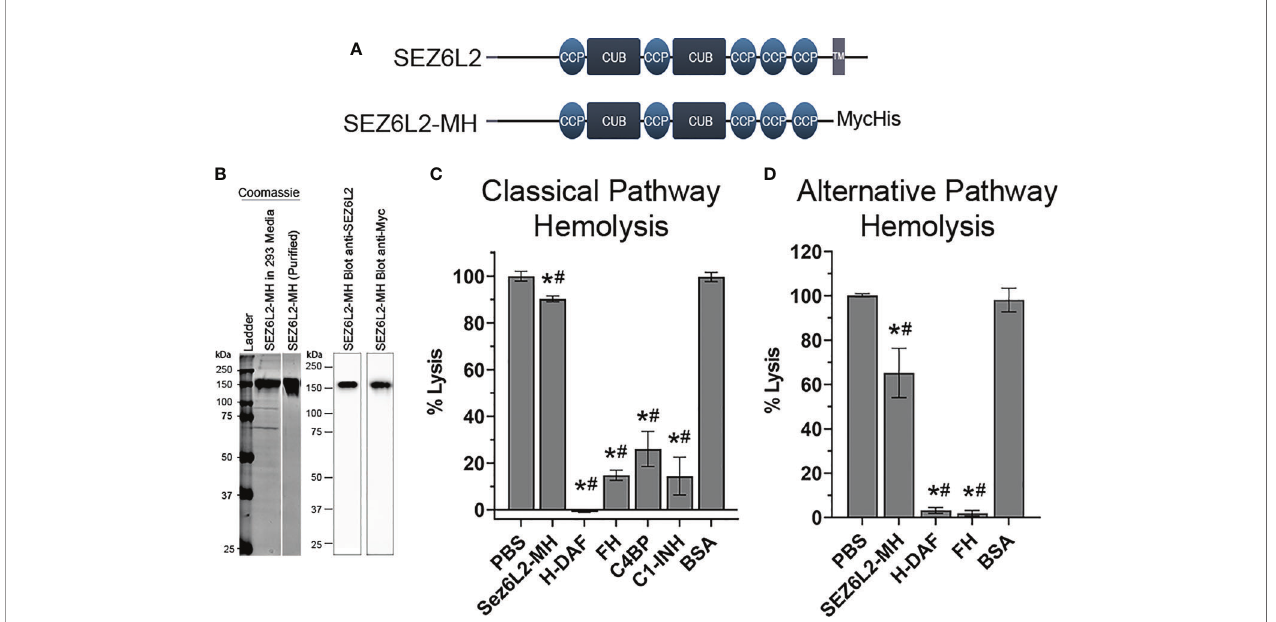
FIGURE 4 | Truncated Sez6L2 inhibits alternative pathway hemolysis more than classical pathway hemolysis. (A) Schematic of Sez6L2 and Sez6L2-MH domain structures. CCP=Domain abundant in complement control proteins. CCP domains are also known as SUSHI repeats or short complement-like repeat (SCR). CUB= Domains named after complement C1r/C1s, uEGF, and BMP1. TM=Transmembrane region. Sez6L2-MH was made by replacing the transmembrane and cytoplasmic tail domains with a tandem Myc, 6xHis tag. (B) Puri fi ed Sez6L2-MH is shown by a Coomassie stained gel and by western blot with anti-Sez6L2 and anti-Myc antibodies. Lanes with the Coomassie stain are from the same gel. (C) Classical pathway hemolysis assay. Antibody-coated sheep erythrocytes were exposed to human serum pre-incubated with puri fi ed Sez6L2-MH, H-DAF, FH, C4BP, C1-INH, or BSA. After 30 mins, the percent of cell lysis was measured by spectrophotometry (A415). One-way ANOVA (P <0.0001; F(6,30)=233.2); PBS N=10; Sez6L2-MH N=7; H-DAF N=4; CFH N=4; C4BP N=3; C1-INH N=3; BSA N=6. (D) Alternative pathway hemolysis assay. Rabbit erythrocytes were exposed to human serum pre-incubated with Sez6L2-MH, complement regulators, or BSA in presence of 10 mM MgEGTA to block the classical pathway. Then the percent of cell lysis was measured by spectrophotometry (A415). One-way ANOVA (P <0.0001; F(4,16)=33.88). PBS N=6, Sez6L2-MH N=5; FH N=2, H-DAF N=2, and BSA N=6. For all graphs *p < 0.05 compared to PBS control and # p < 0.05 compared to BSA negative